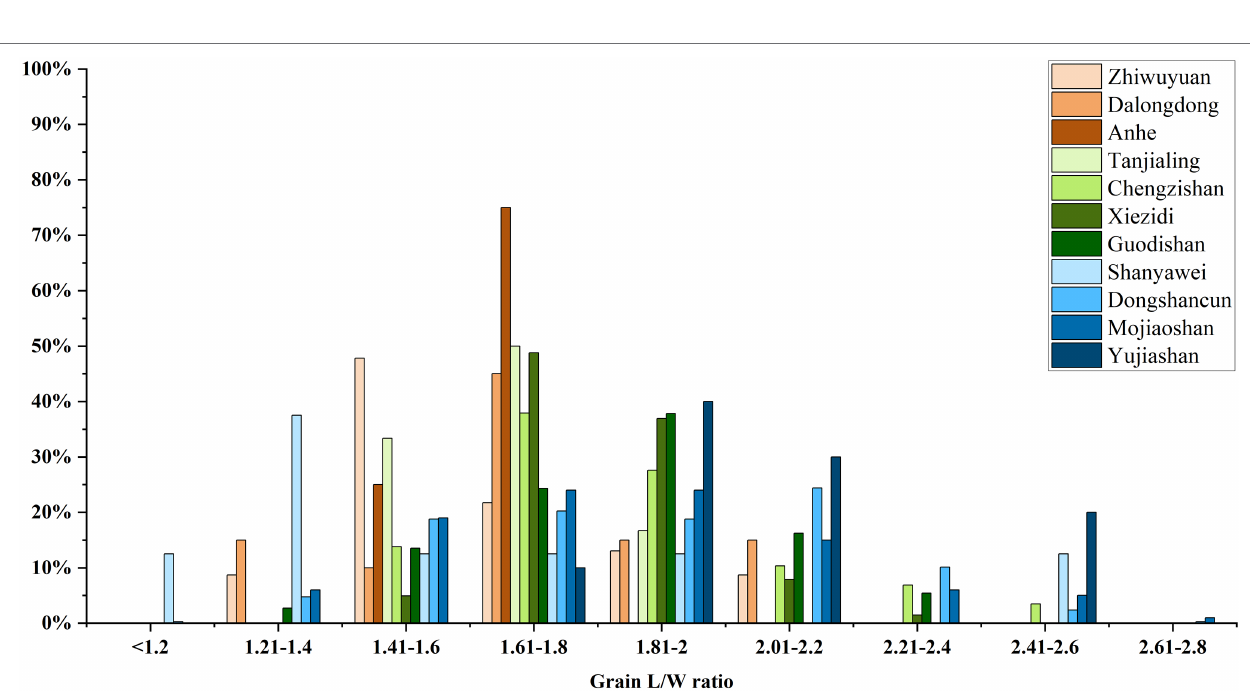
FIGURE 7 | Assemblage of plant remains from the Zhiwuyuan site. (A) Proportions of different plant remains of the Early Xuntangpu phase and Zhiwuyuan phase from Zone A and B, (B) proportions of different types of rice remains of the Early Xuntangpu phase from Zone A, and (C) proportions of different kinds of foxtail millet remains of the Early Xuntangpu phase from Zone A.